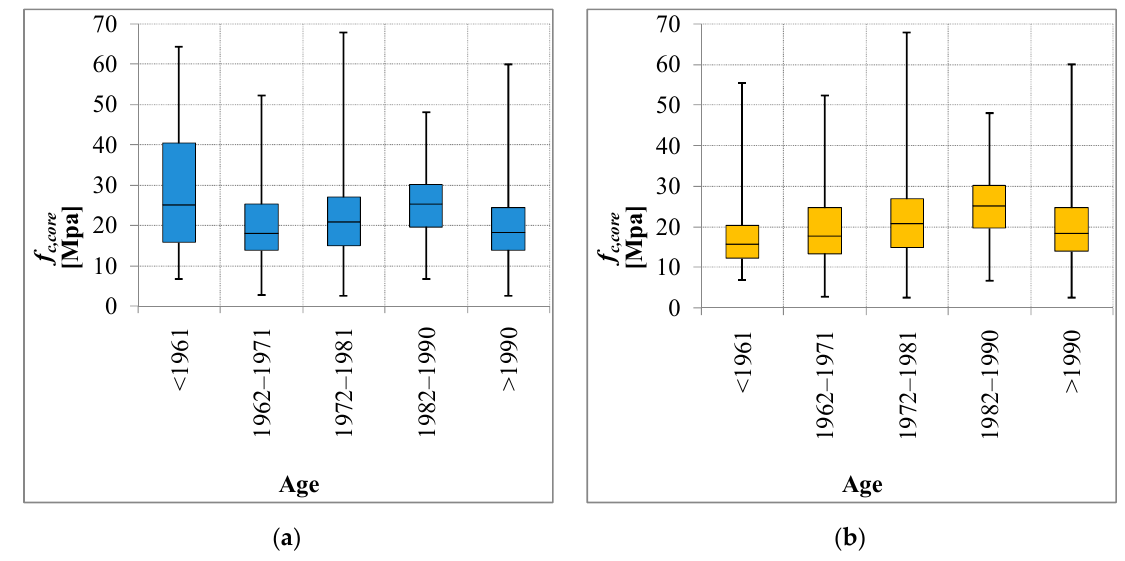
Figure 5. f c,core —Age comparison with ( a ) or without ( b ) civil engineering works. Each box encloses 50% of the data with the median value of the maximum f c,core displayed as a thin line, within the box; the top and the bottom of the box, respectively, mark the 25% and 75% limits of the population; outside the box, the whiskers represent the maximum and minimum values of the population, respectively.